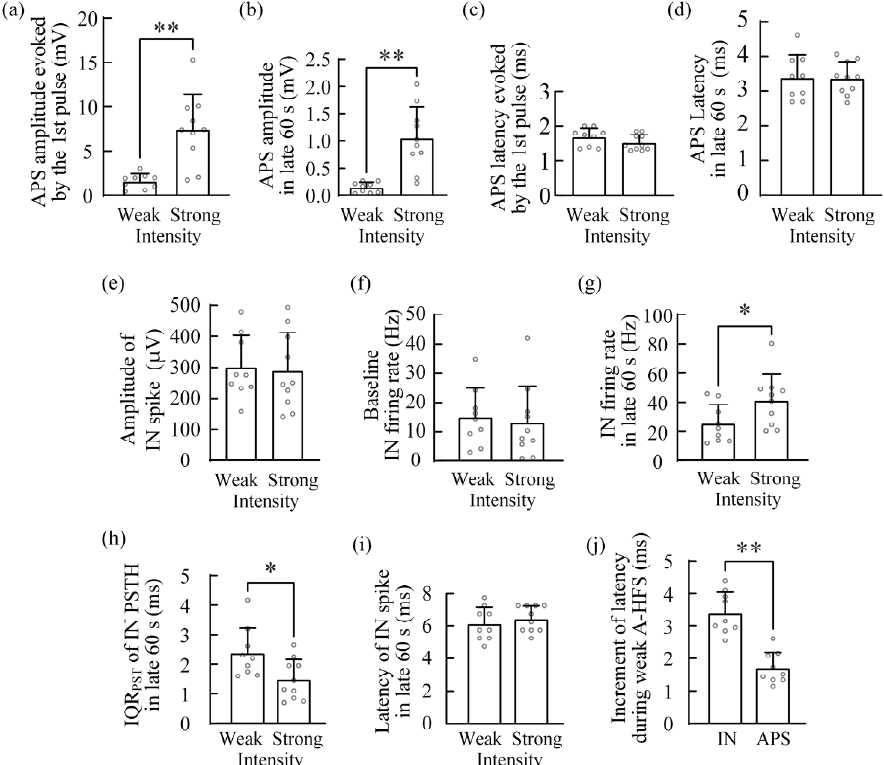
Figure 4. Comparisons of the data between the two A-HFS groups with weak- and strong-intensity pulses. ( a – d ) Comparisons of the mean initial APS amplitudes ( a ), the mean APS amplitudes in the late 60 s of A-HFS ( b ), the mean initial APS latencies ( c ) and the mean APS latencies in the late 60 s of A-HFS ( d ). ( e – g ) Comparisons of the amplitudes of IN spikes ( e ), the baseline IN firing rates ( f ) and the IN firing rates in the late 60 s of A-HFS ( g ). ( h ) Comparison of IQR PST of IN firing in the late 60 s of A-HFS. ( i ) Comparison of the latency of IN spikes in the late 60 s of A-HFS. ( j ) Comparison of the latency increments (i.e., for IN spike: the peak time of PSTH in the late 60 s minus the latency following the 1st pulse; for APS: mean latency in the late 60 s minus the latency following the 1st pulse.) between the IN spikes and the APS caused by weak A-HFS. * p < 0.05, ** p < 0.01, ( a – i ) unpaired t -test, ( j ) paired t -test, weak group: n = 9 rats, strong group: n = 10 rats.